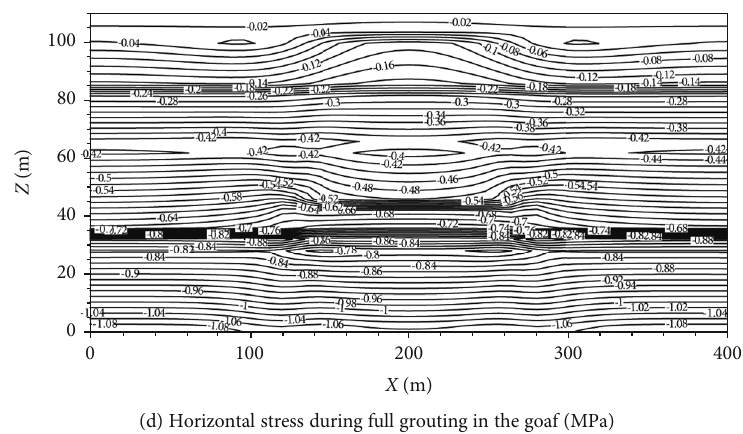
Figure 6: Displacement stress distribution diagram during full grouting in the